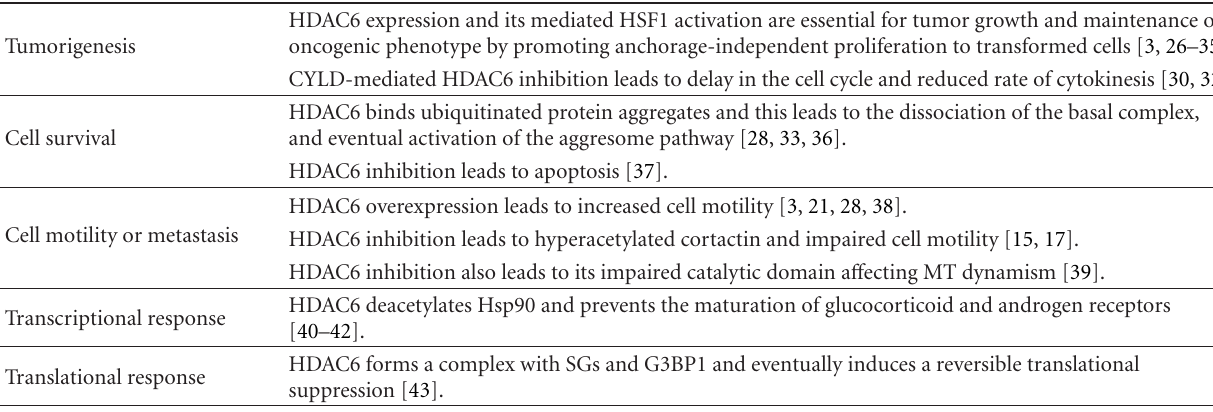
Table 1: Overview of HDAC and its role in